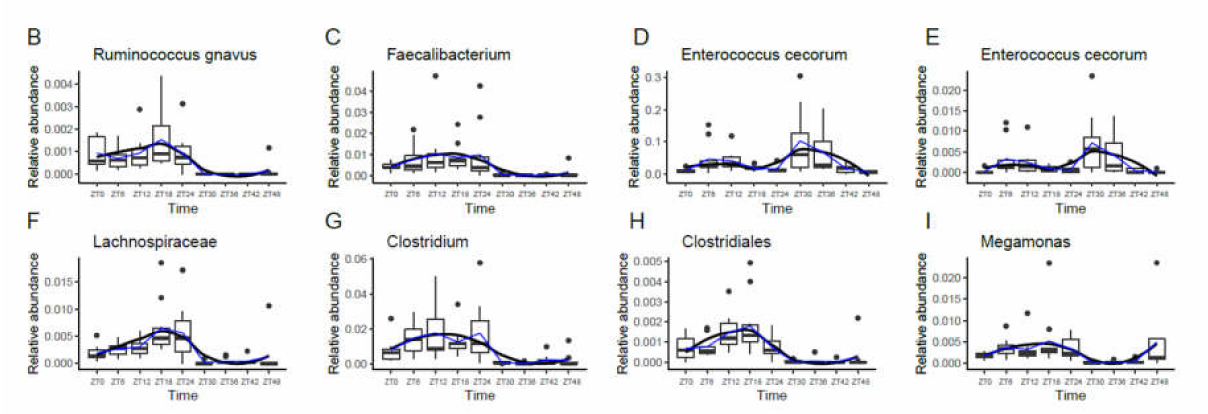
Figure 3. The most abundant bacteria were identified by random forest analysis. ( A ) Tracing the source of the top 30 most abundant bacteria in the fecal microbiota; ( B – I ) The temporal changes in the relative abundance of the eight most important bacteria. The black line represents the fitted trend line and the blue line represents the connecting line of the average